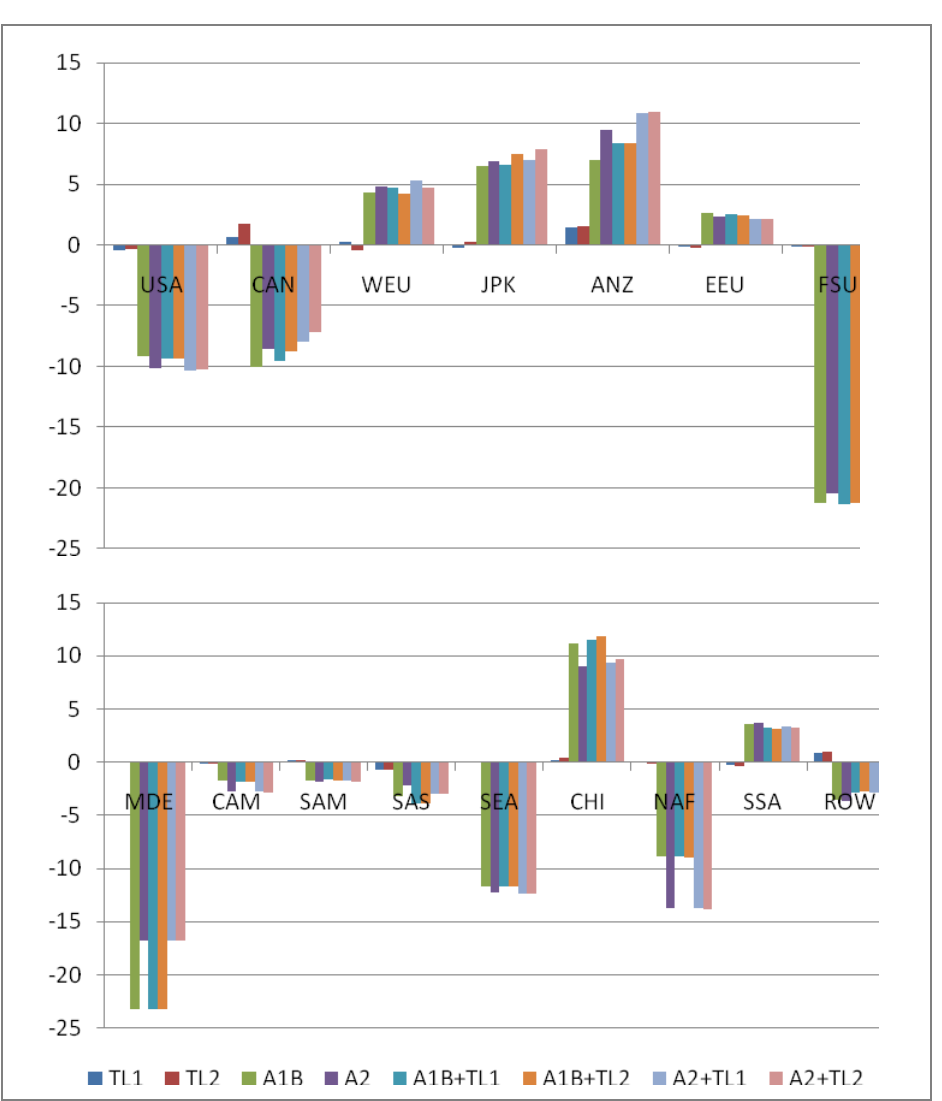
Figure 3. Change in agricultural production in 2050 (in %) relative to the baseline.